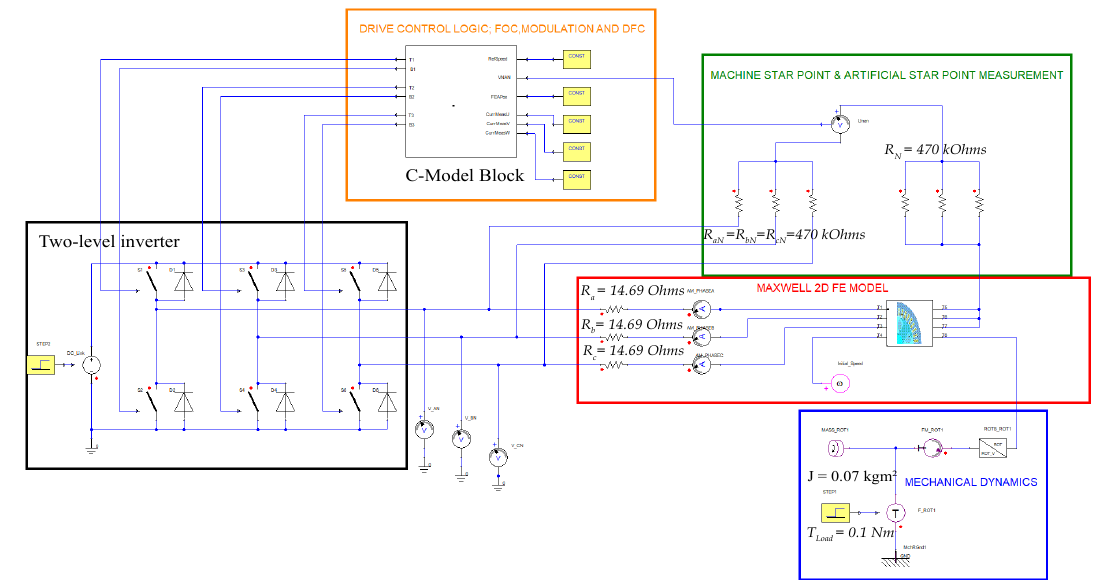
Figure 11. Sensorless speed control with field oriented control and SVM-based DFC measurement sequence, Simplorer-Maxwell co-simulation model.